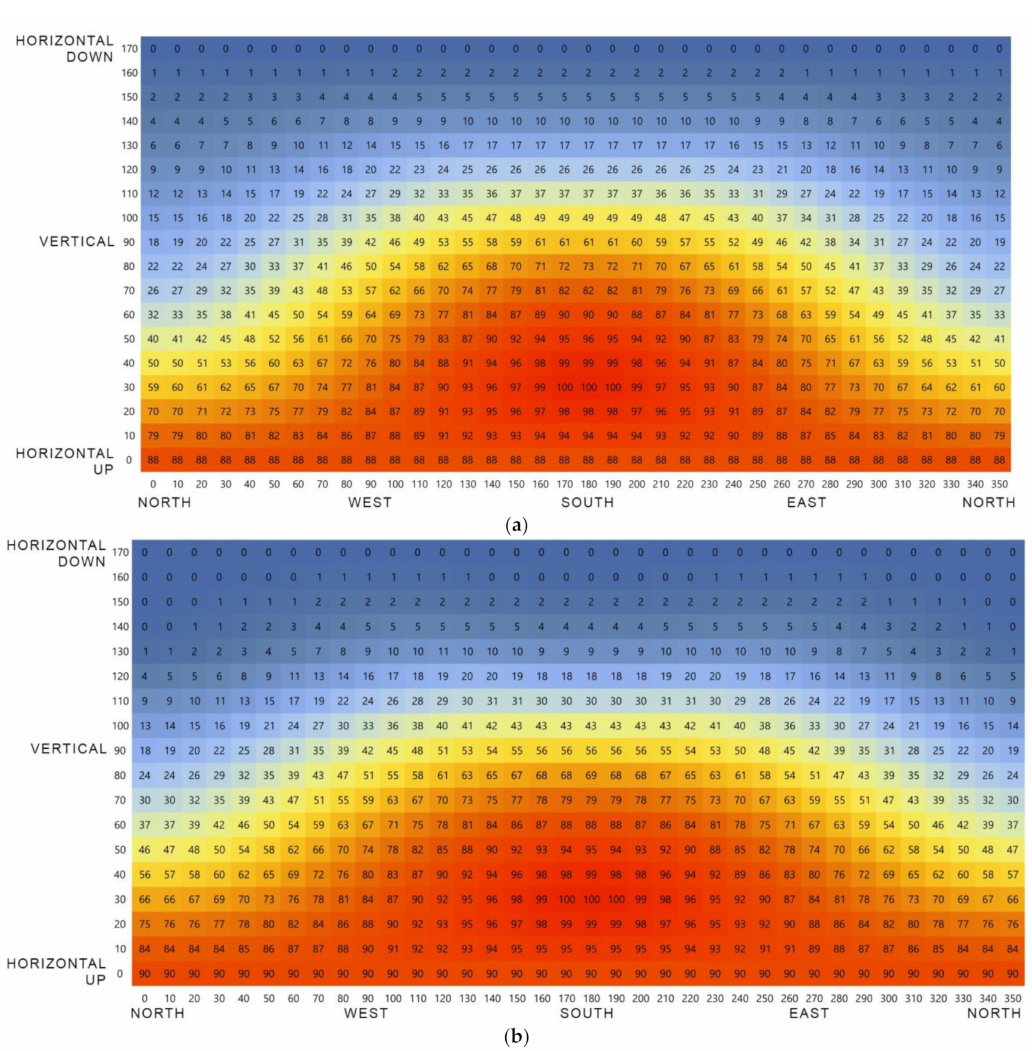
Figure 2. Solar potential Φ sol [%] for every 10 ◦ of spatial rotation of an abstract plane in the solar conditions of Bratislava. ( a ) Calculation with Ladybug. ( b ) Calculation with the model by Kittler and